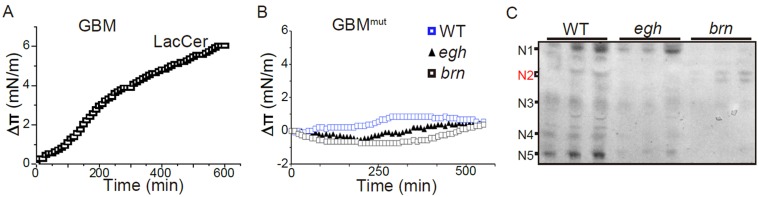
Additional monolayer data and GSL profiles of egh and brn mutants.(A) Surface pressure increase (Δπ) by the addition of the Wg233-247 (GBM) peptide on a monolayer of LacCer. A maximal value was reached after 1 hr of incubation. (B) Surface pressure change (Δπ) by the addition of mutated GBM at Lys and Met (GBMmut) on a monolayer of GSLs purified from wild type, egh62d18 and brn1.6P6 larvae. All surface pressure measurements were performed in triplicate and a representative curve is shown. (C) GSL profile of wild type, egh62d18 and brn1.6P6 extracts (Ceramide mono-, di-, tri-, tetra- and penta-hexoside are denoted as N1, N2, N3, N4 and N5, respectively). Wild-type larvae express a broad range of GSLs including tetra- and penta-hexosylceramides, while egh62d18 mutants lacked MacCer and brn1.6P6 mutants contained almost exclusively MacCer (N2).